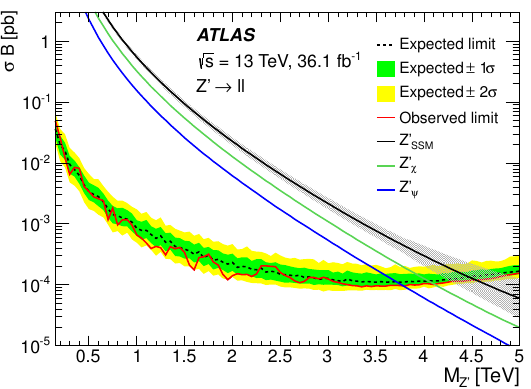
Figure 4 . Upper 95% CL limits on the Z 0 production cross-section times branching ratio to two leptons of a single (cid:13)avour as a function of Z 0 pole mass (M Z 0 ). Results are shown for the combined dilepton channel. The signal theoretical (cid:27)B are calculated with Pythia 8 using the NNPDF23LO PDF set [36], and corrected to next-to-next-to-leading order in QCD using VRAP [28] and the CT14NNLO PDF set [29]. The signals theoretical uncertainties are shown as a band on the Z 0 theory line for illustration purposes, but are not included in the (cid:27)B limit